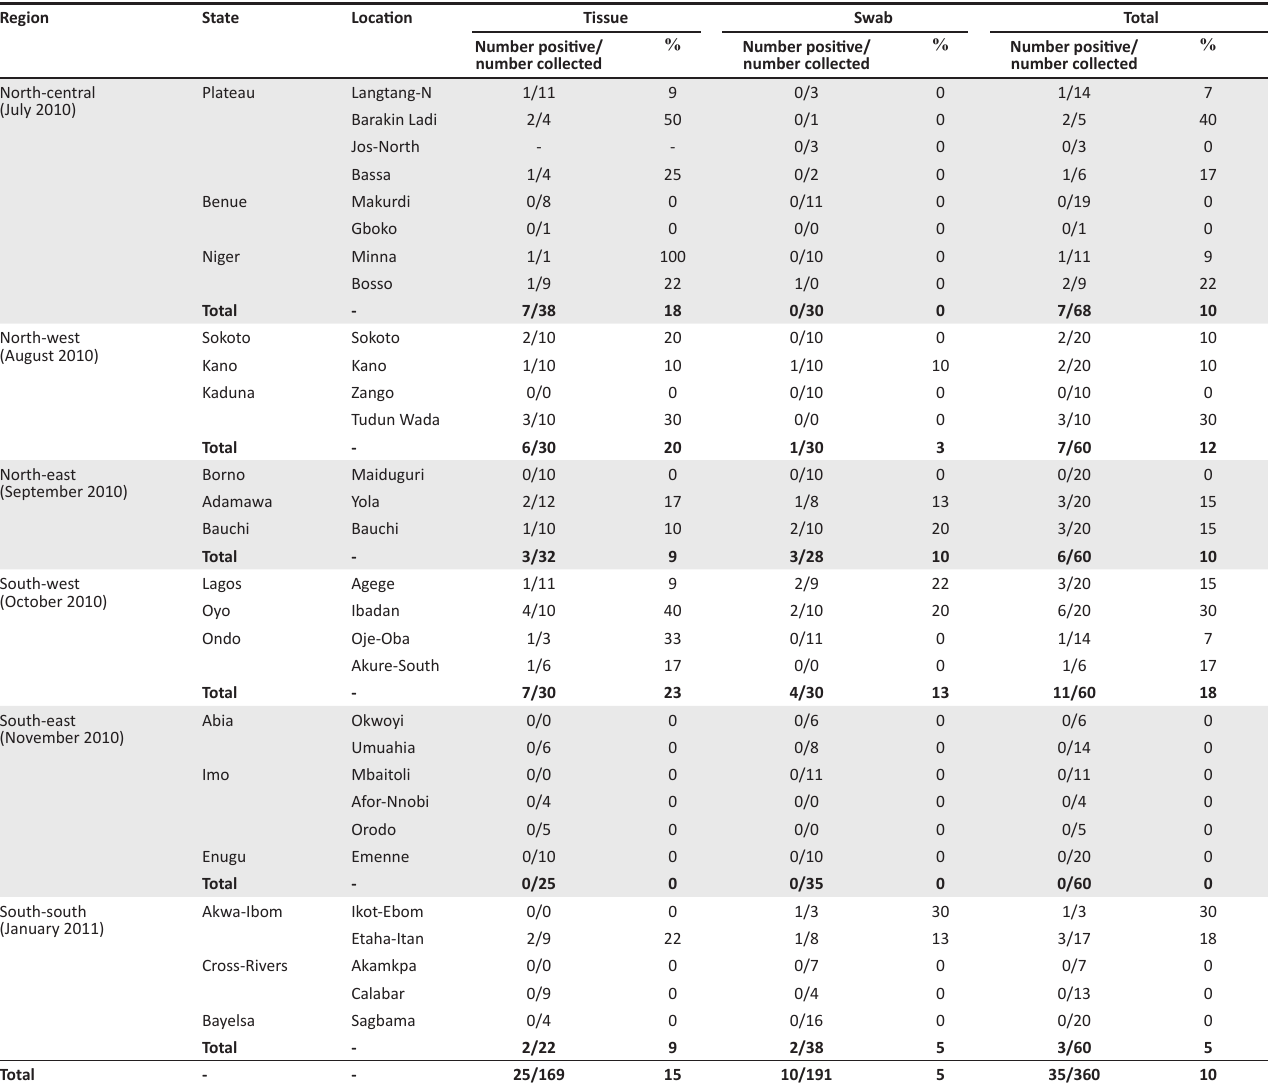
TABLE 2: Description of the regions, study areas and period of sample collection, location and numerical number of positives in percentage and total number of samples collected.